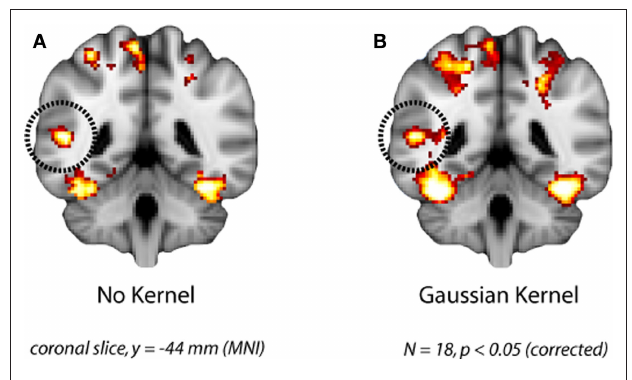
FIguRe A3 | effect of kernel in experiment 2. (A) Group analysis of resting correlations with each subject’s peak face-selective FG voxel after removing variance from the peak scene-selective PHC voxel. (B) Group analysis of resting correlations when an 8-mm FWHM Gaussian kernel centered on the peak voxel was used to define the seed and control